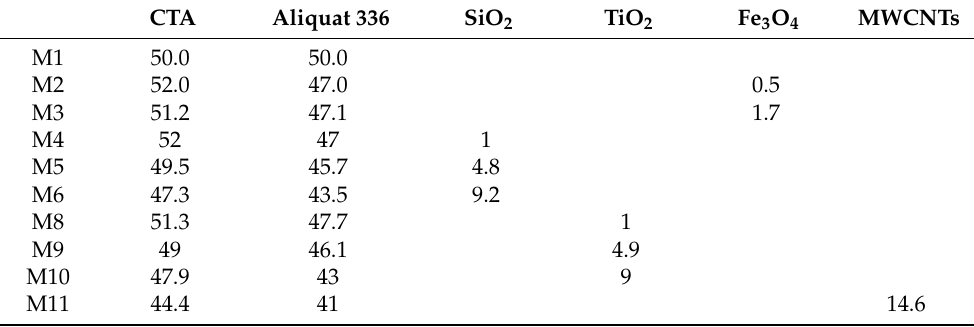
Figure 2. Scheme of the preparation of nanoparticle-doped polymer inclusion membranes (NP-PIMs). Table 1. Composition (% w / w ) of the NP-PIMs prepared for the present